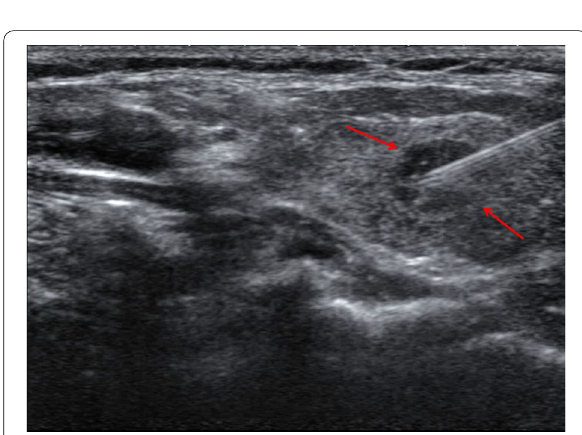
Fig. 4 The ultrasound-guided fine-needle aspiration from a hypoechoic solid nodule with regular margin, punctate echogenic foci, and a diameter of 6 mm (ACR-TIRADS-5, ATA-2015-High suspicion, K-TIRADS-5), which was proved by cytology to be a papillary